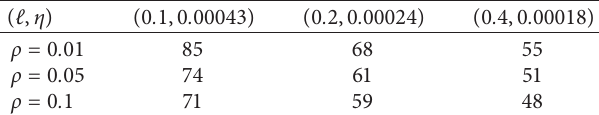
Table 1: Amount of date communication under varying ℓ , η , and ρ